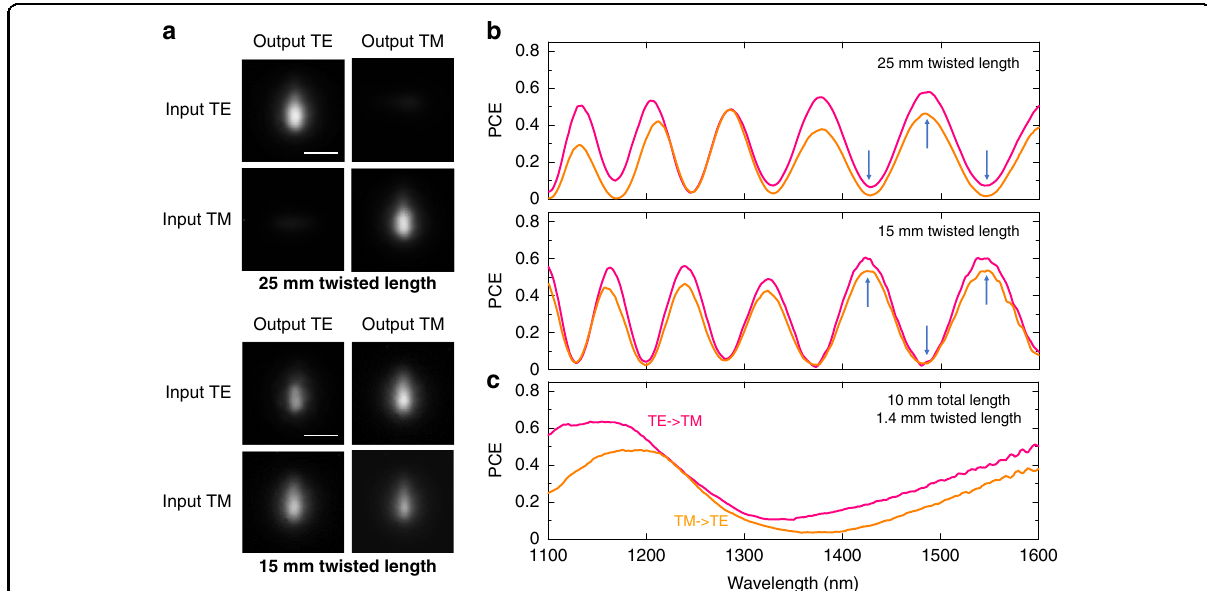
Fig. 5 Demonstration of on-chip polarization manipulation of SPIM-WGs. All images (LED, laser) have the same frame size of 30 × 30 µm. Scale bars are 10 µm. a Results of polarization-controlled experiments at 1550 nm wavelength laser. Top: twisted waveguide with 25 mm twisted length. Bottom: twisted waveguide with 15 mm twisted length. Images are waveguide mode pro fi les observed for particular output polarization state, with input laser light of either pure TE or pure TM polarization. Both waveguides have total length of 30 mm. b Measured polarization conversion PCE for twisted waveguides with total length of 30 mm, different twisted lengths of 25 mm and 15 mm, at wide near-infrared wavelengths. PCEs are controllable for any target wavelength by modifying twisted length while fi xing total length. Red curve is measured with horizontally polarized input laser, while orange curve is vertical polarized input laser. c Measured polarization conversion PCE for twisted waveguides with total length of 10 mm, twisted lengths of 1.4 mm, at wide near-infrared wavelengths. The polarization manipulation behavior of straight rectangular waveguides was measured for comparison in Supplementary Fig. S9. In this fi gure, Waveguide cross-section sizes are 20 × 4 µm for all. Twisted waveguides are with 90° twisting